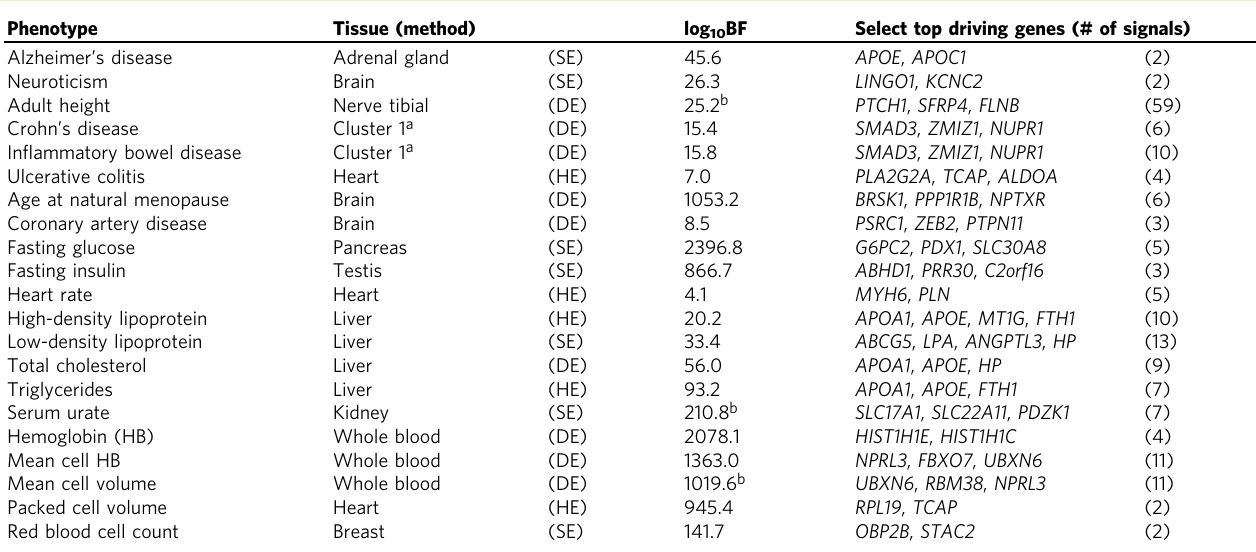
Table 3 Top enriched tissue-based gene sets in complex traits Phenotype